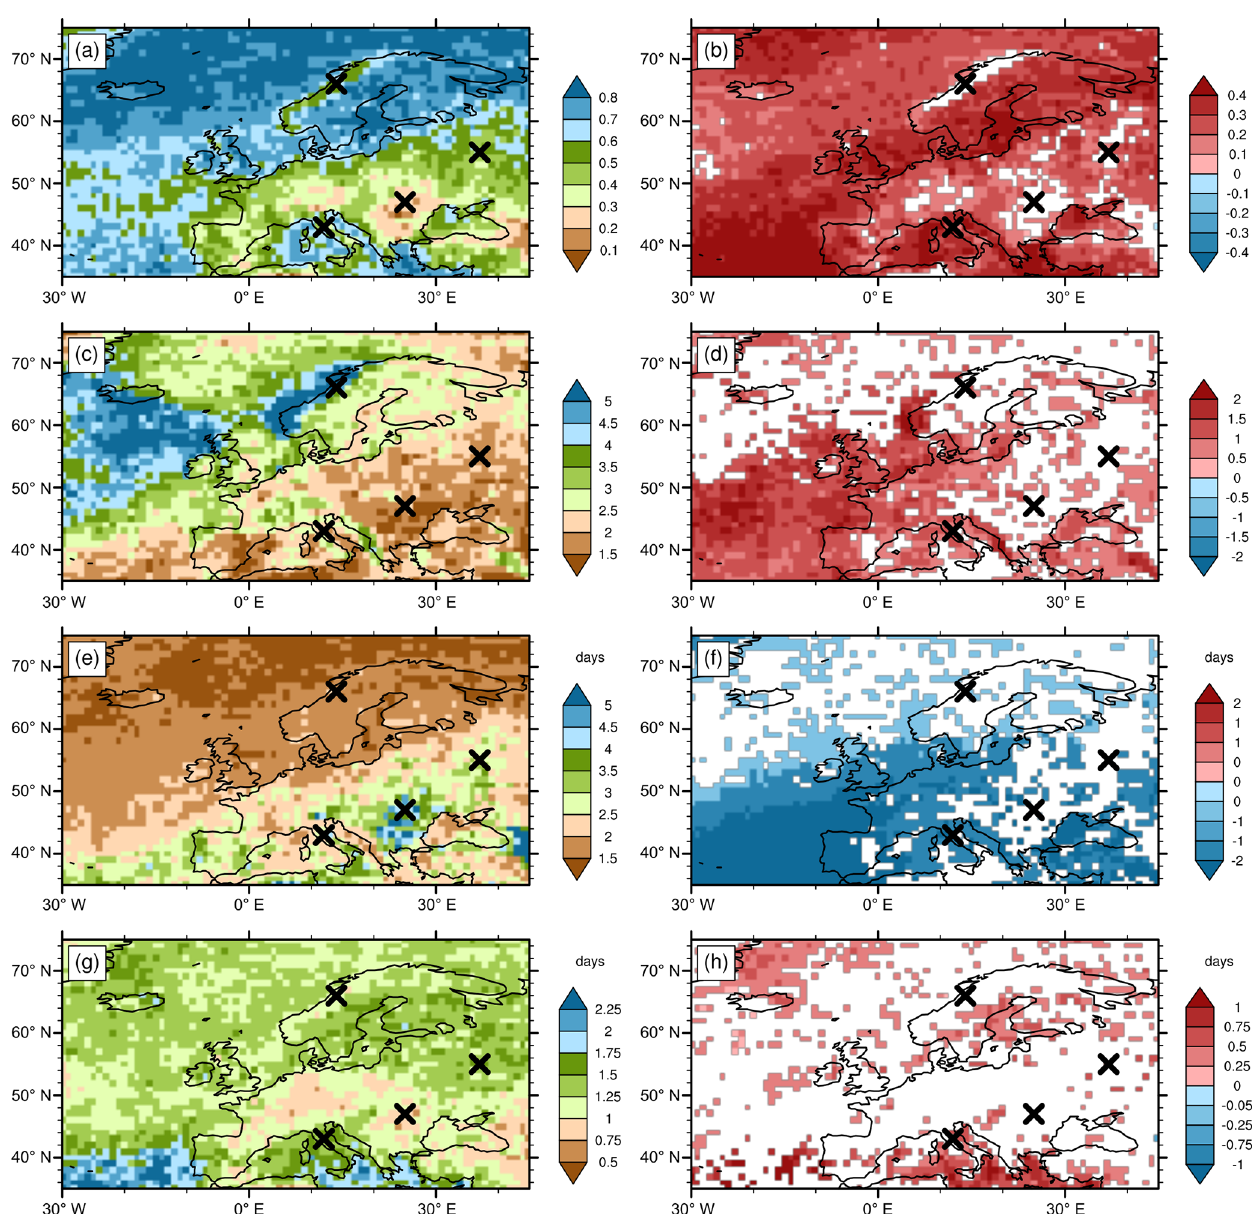
Figure 8. Cyclone characteristics during the S 20 (left column) and their respective anomalies (right column; see Sect. 2.5 for the technical definition of the four quantities and their climatological values). (a, b) The cyclone fraction, F cyclone , i.e. fraction of total S 20 time steps with a cyclone, (c, d) number of distinct cyclones per S 20 , N cyclone , (e, f) the cyclone period, P cyclone , i.e. summed S 20 duration divided by number of distinct cyclones, and (g, h) the residence time, R cyclone , i.e. the average time each distinct cyclone affects one of the S 20 . Statistically not significant values in panels (b) , (d) , (f) , and (h) are masked out in white (see Sect. 2.5 for